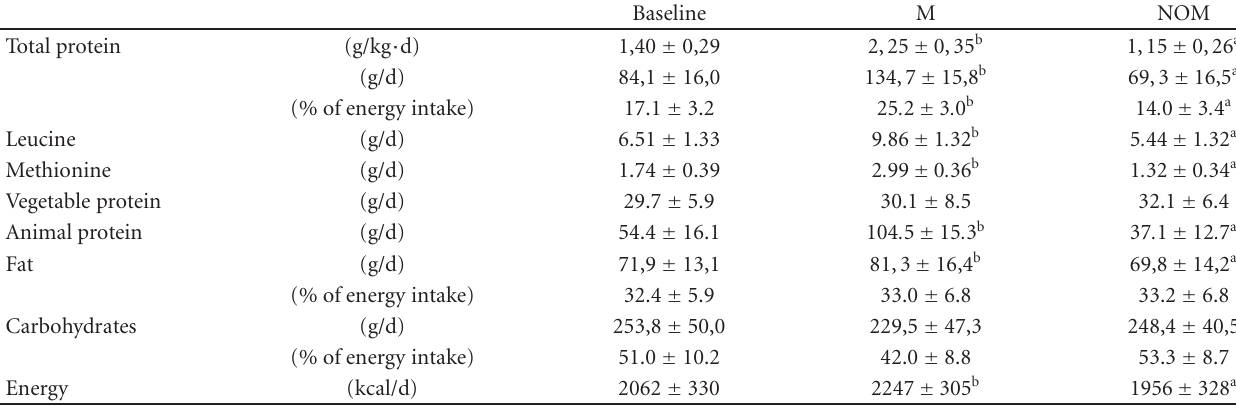
Table 2: Nutrient intakes of women at baseline and during 4 weeks periods of consuming diets with either additional meat content (M, 200g pork fillet/d) or exclusion of meat products (NOM). 1